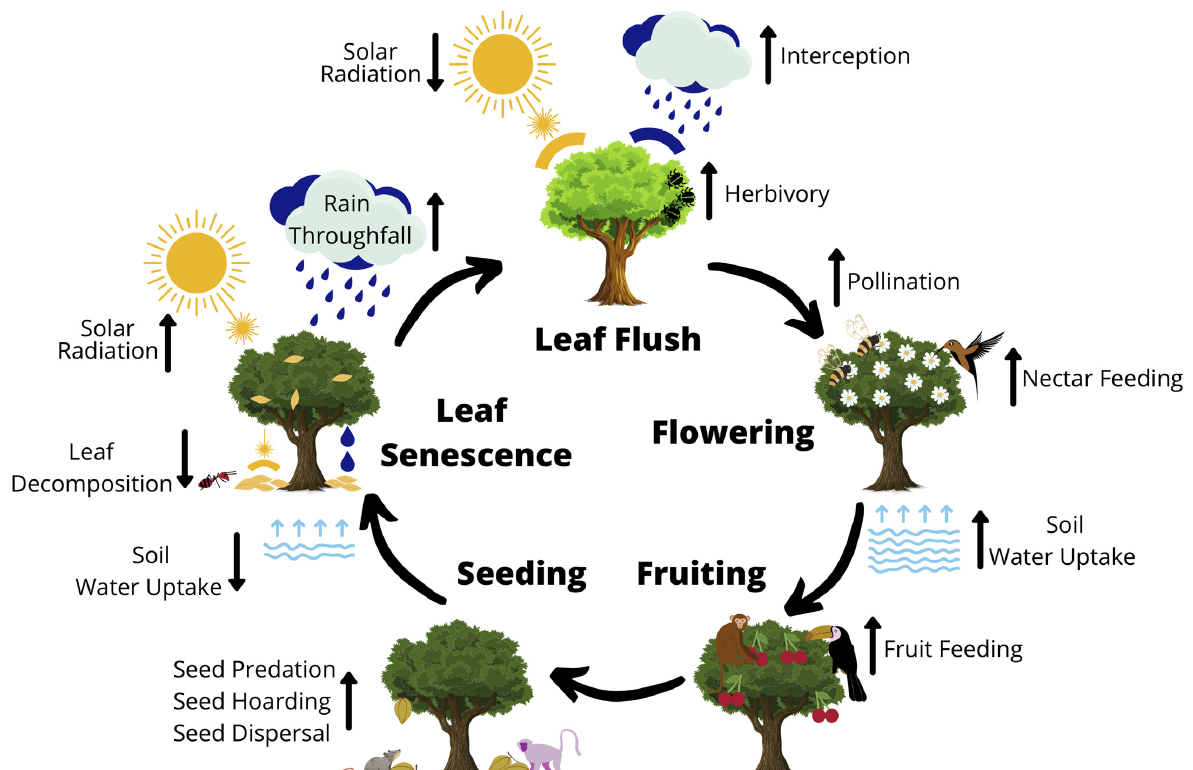
Figure 2. Ecosystem processes and conditions that drive phenological events. References giving examples for the effect of phenology on ecological processes are: increased interception [38], increased herbivory [48], increased pollination [49–51], increased nectar feeding [52], increased soil water uptake [38–43], increased fruit feeding [53,54], increased seed hoarding [55], increased seed dispersal [55], increased seed predation [56], decreased soil water uptake [38–43], decreased leaf decomposition [56], increased solar radiation [2,38,43], increased rain throughfall [38], and decreased solar radiation [2,38,43].